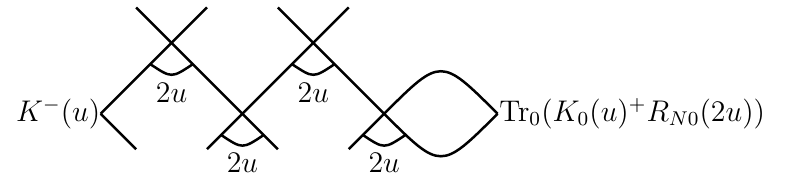
Figure 6 . A rearrangement of the lattice in figure 5—the two lattices are topologically equivalent and correspond to the same transfer